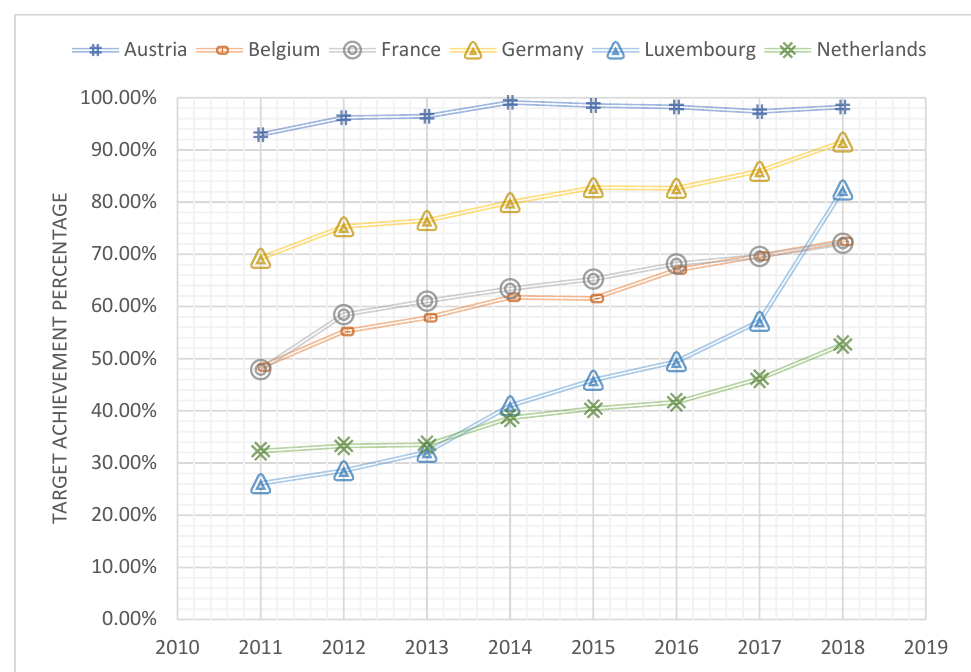
Figure 7. Renewable energy consumption rate normalized to the 2020 target.